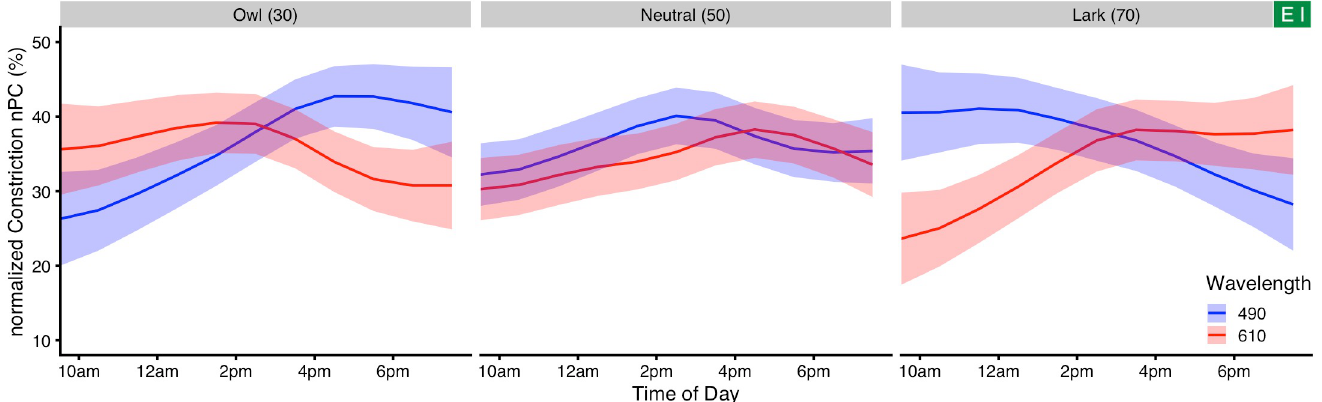
Fig 10. Select changes of nPC across the day in Experiment I . Model predictions for the nPC vs. time of day for three chronotypes (left to right), and two wavelengths (blue trace 490 nm and red trace 610 nm), that were chosen for comparison with the studies by Zele et al. [27] and Munch et al. [26]. Ribbons show the 95% confidence interval for the predicted